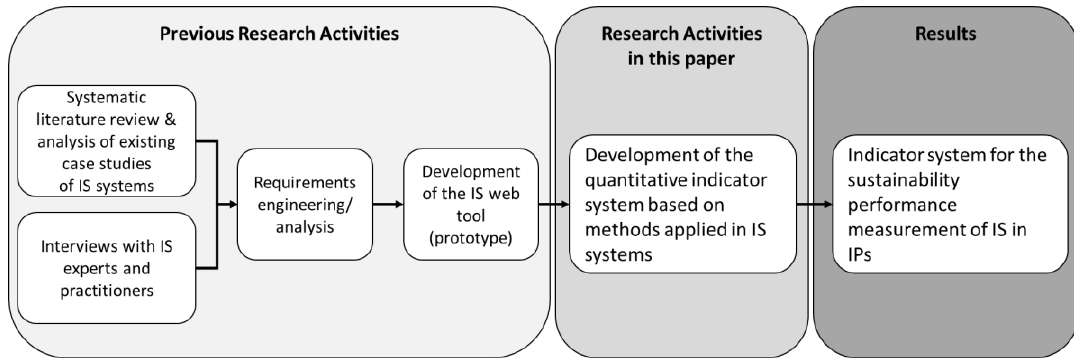
Figure 3. Design of the research